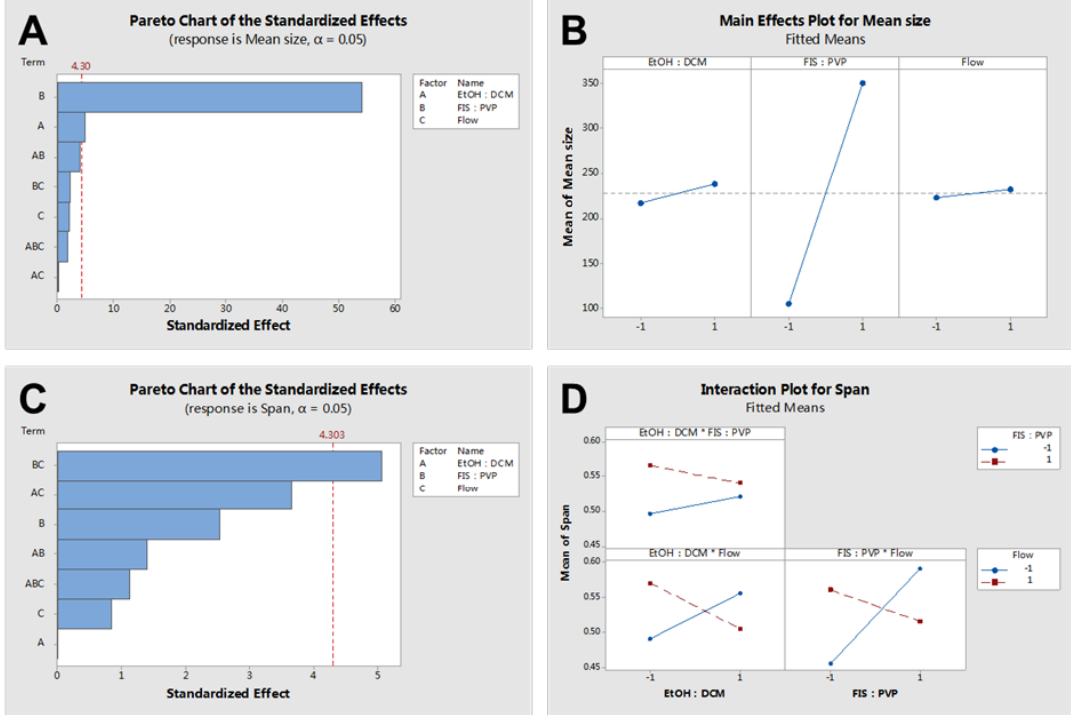
Figure 5. ( A ) Standardized effects of the factors on mean size, ( B ) a main effects plot for mean size, ( C ) standardized effects of the factors on span, and ( D ) an interaction plot for the span.